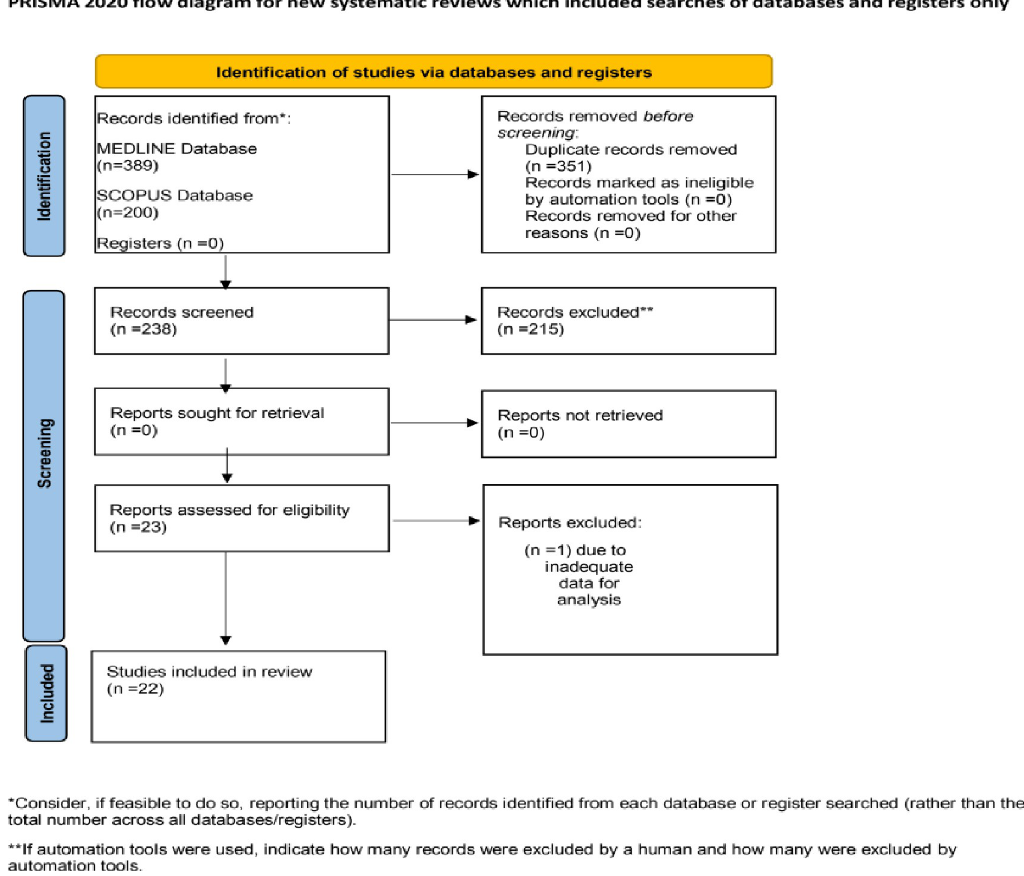
Fig 1. The PRISMA